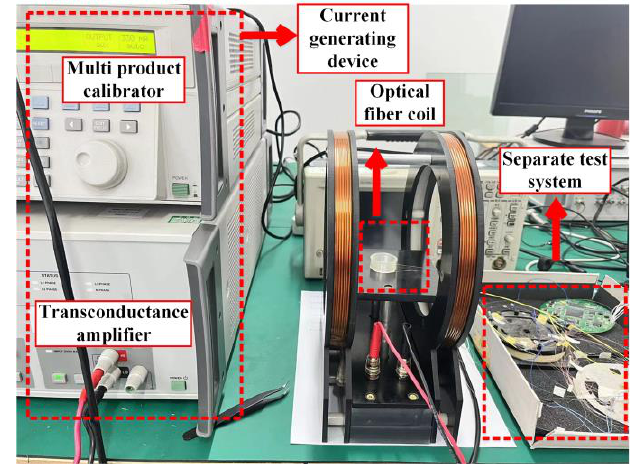
Figure 8. Magnetic error test experiment of radial magnetic field.